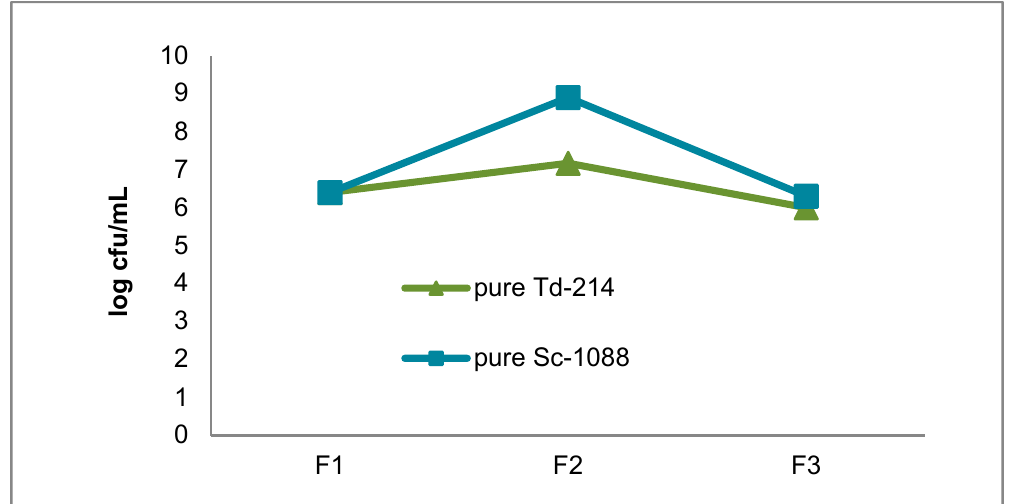
Figure 1. The growth of yeasts during pure culture fermentations. Pure Td-214: pure T. delbrueckii -214, pure Sc-1088: pure S. cerevisiae -1088. F1: beginning of fermentation. F2: middle of fermentation. F3: end of fermentation.